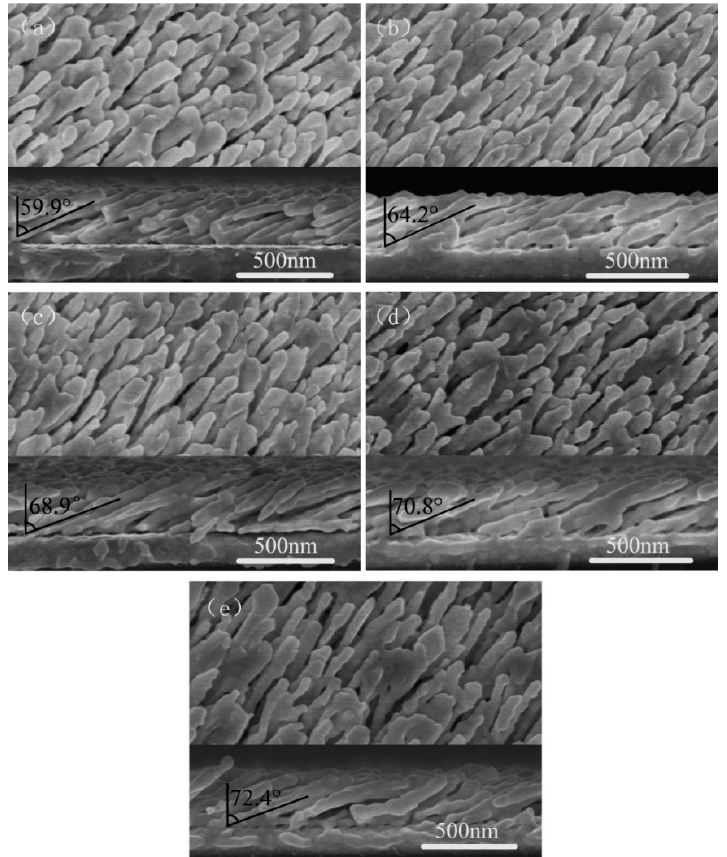
Figure 6. The SEM images of AuNRs deposited at different deposition angle θ : ( a ) θ = 80°, ( b ) θ = 82°, ( c ) θ = 84°, ( d ) θ = 86°, ( e ) θ = 88°. The upper part of each image is the top-view and the lower part is the cross-section view.